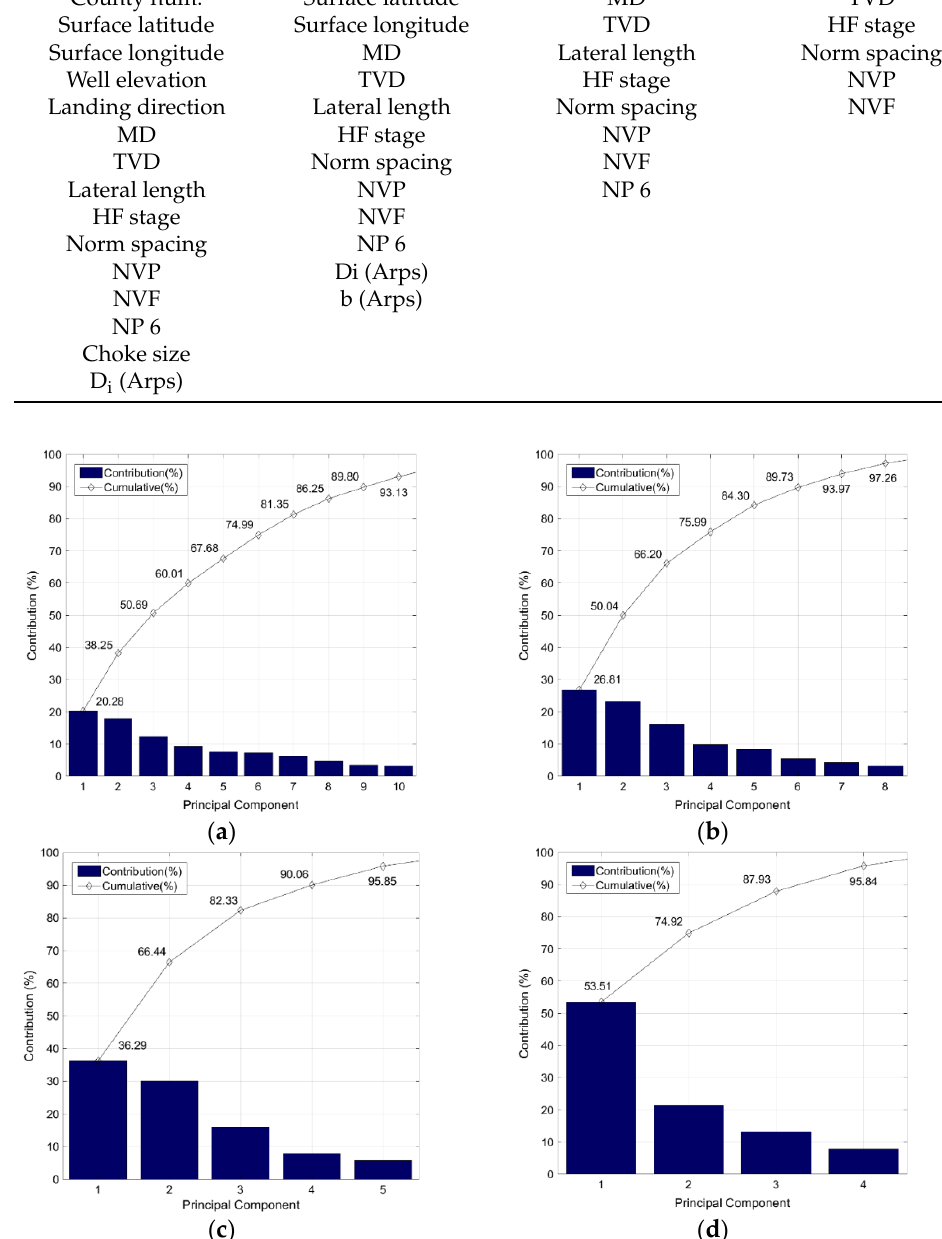
Figure 9. Scree plot of PCA results for all cases: ( a ) Case 1; ( b ) Case 2; ( c ) Case 3; ( d ) Case 4.